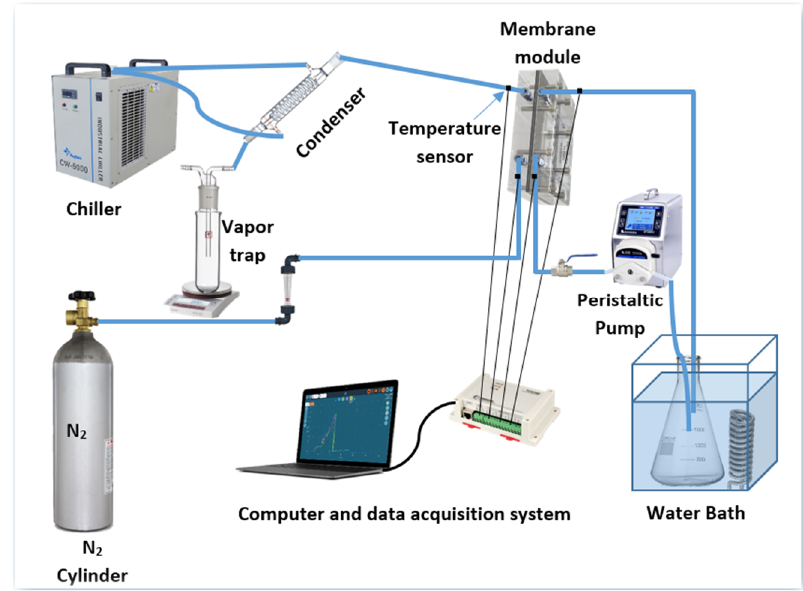
Figure 1. Schematic diagram of the experimental rig for the SGMD process.